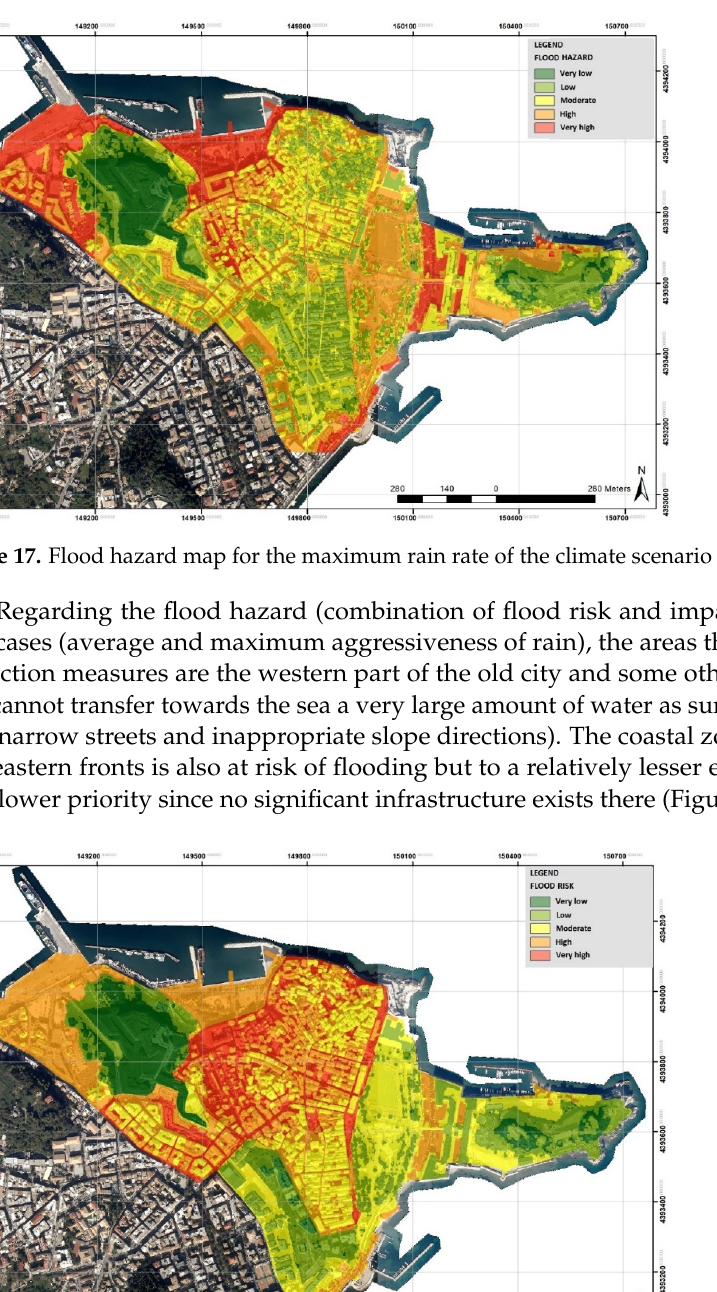
Figure 18. Flood risk map for the average rain rate of the reference period (1971–2004) .